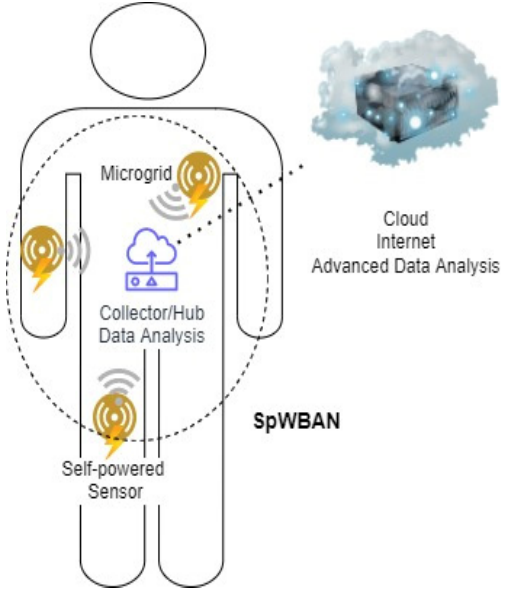
Figure 2. System model of SpWBAN.